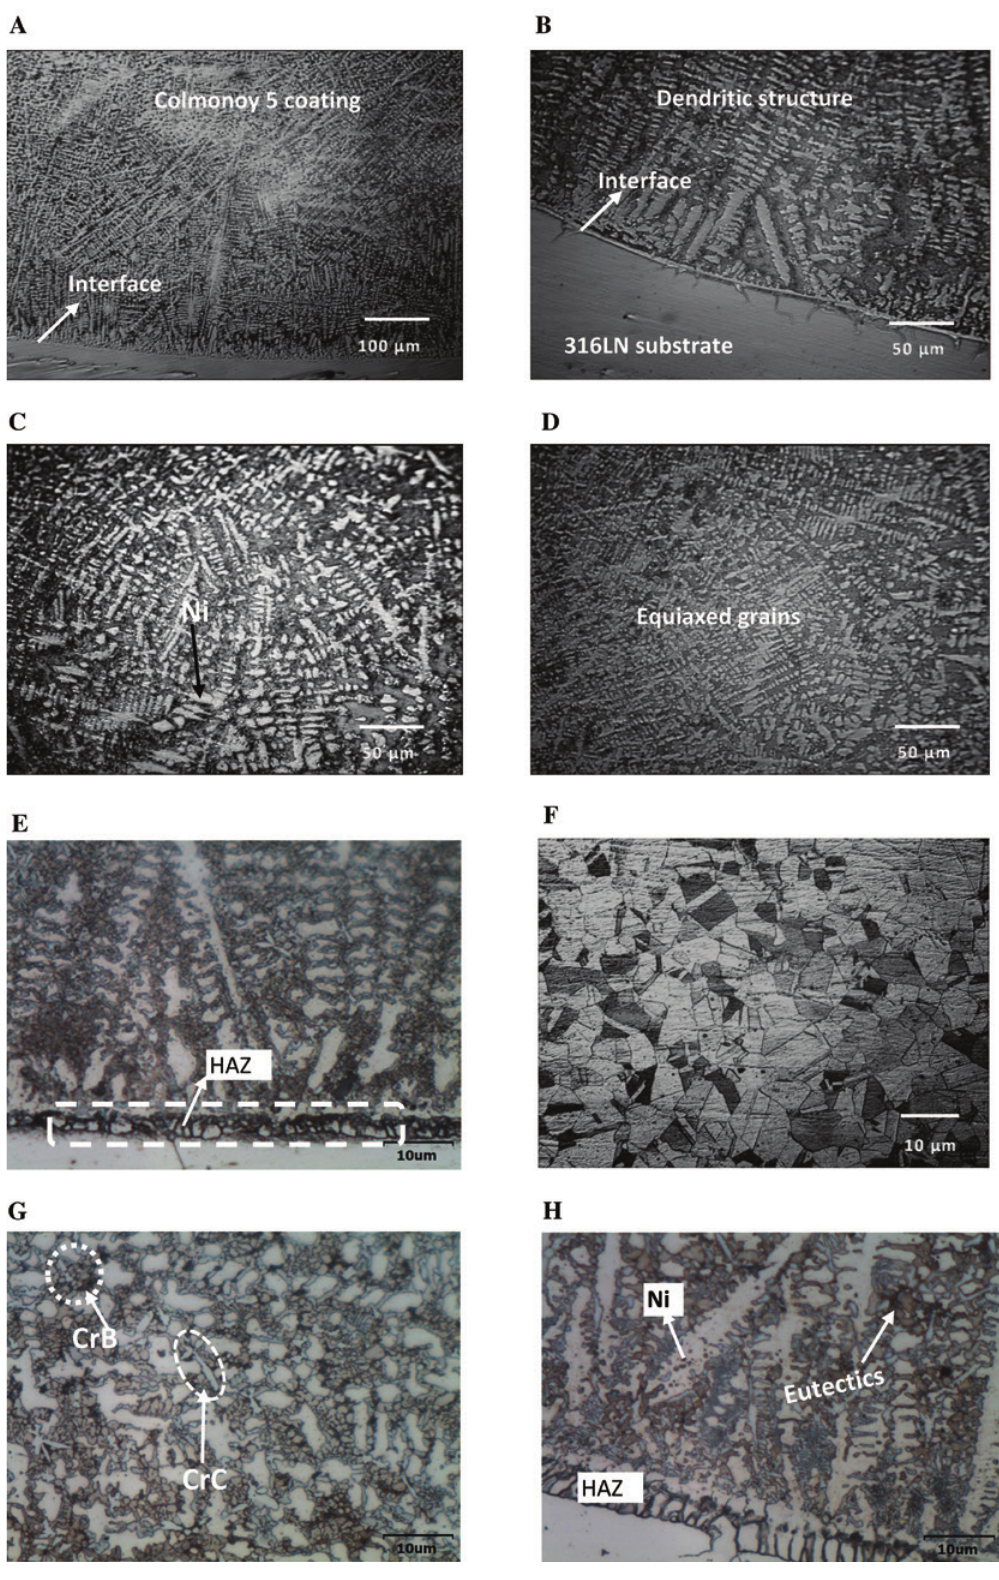
Figure 7: Various microstructures of hardfaced deposits observed by